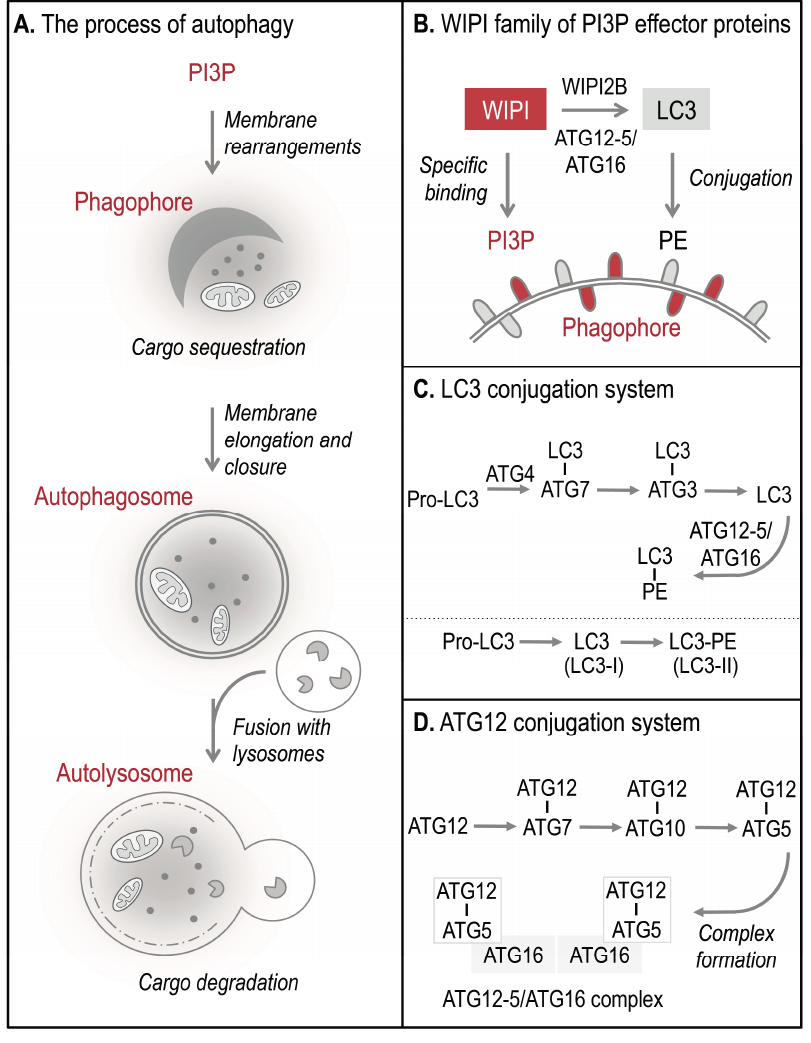
Figure 1. The process of WIPI-mediated autophagy. The process of autophagy is initiated by ER-localized production of PI3P leading to the formation of a template membrane, referred to as a phagophore (or isolation membrane) by unknown steps of membrane rearrangements ( A ). The phagophore elongates by sequestering cytoplasmic cargo, including proteins, lipids, membranes, and organelles, and closes to form a double-membrane vesicle called an autophagosome. Subsequently, the autophagosome delivers the sequestered cargo to the lysosomal compartment for final degradation. During this process the autophagosome fuses with lysosomes to form so-called autolysosomes, where the inner autophagosomal membrane and the cargo are rapidly degraded and the components are released into the cytosol for subsequent recycling or storage purposes. WIPI proteins function as essential PI3P-effector proteins at the nascent autophagosome ( B ). WIPI proteins specifically bind to PI3P and WIPI2B promotes the conjugation of LC3 to PE (LC3 lipidation) through the recruitment of the ATG12-5/ATG16 complex. LC3 lipidation is initiated by C-terminal cleavage of pro-LC3 by ATG4, which becomes conjugated to PE via ATG7 and ATG3 ( C ). Conjugation of LC3 to PE, (LC3-PE, also referred to as LC3-II) requires the ATG12-5/ATG16 complex. ATG12-5/ATG16 complex formation is initiated by the conjugation of ATG12 to ATG5 (ATG12-5), via ATG7 and ATG10 ( D ). Subsequently, ATG16 associates with ATG12-5 to form the multiprotein ATG12-5/ATG16